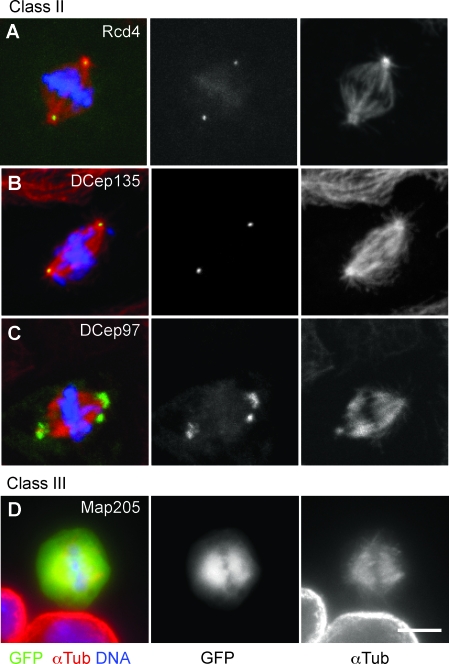
Localisation of Several Newly Identified Centrosome/Spindle Components by GFP-TaggingS2 cells stably transfected with GFP-constructs expressing Rcd4 (CG17295) (A), DCep135 (B), DCep97 (C), or Map205 (D) under the control of the metallothionein promotor (pMT) were induced for 24 h, fixed with paraformaldehyde, and costained with Hoechst (DNA) and anti–α-tubulin antibodies. The merged picture shows the GFP-fusion protein in green, α-tubulin in red, and DNA in blue. Scale bar represents 5 μm.